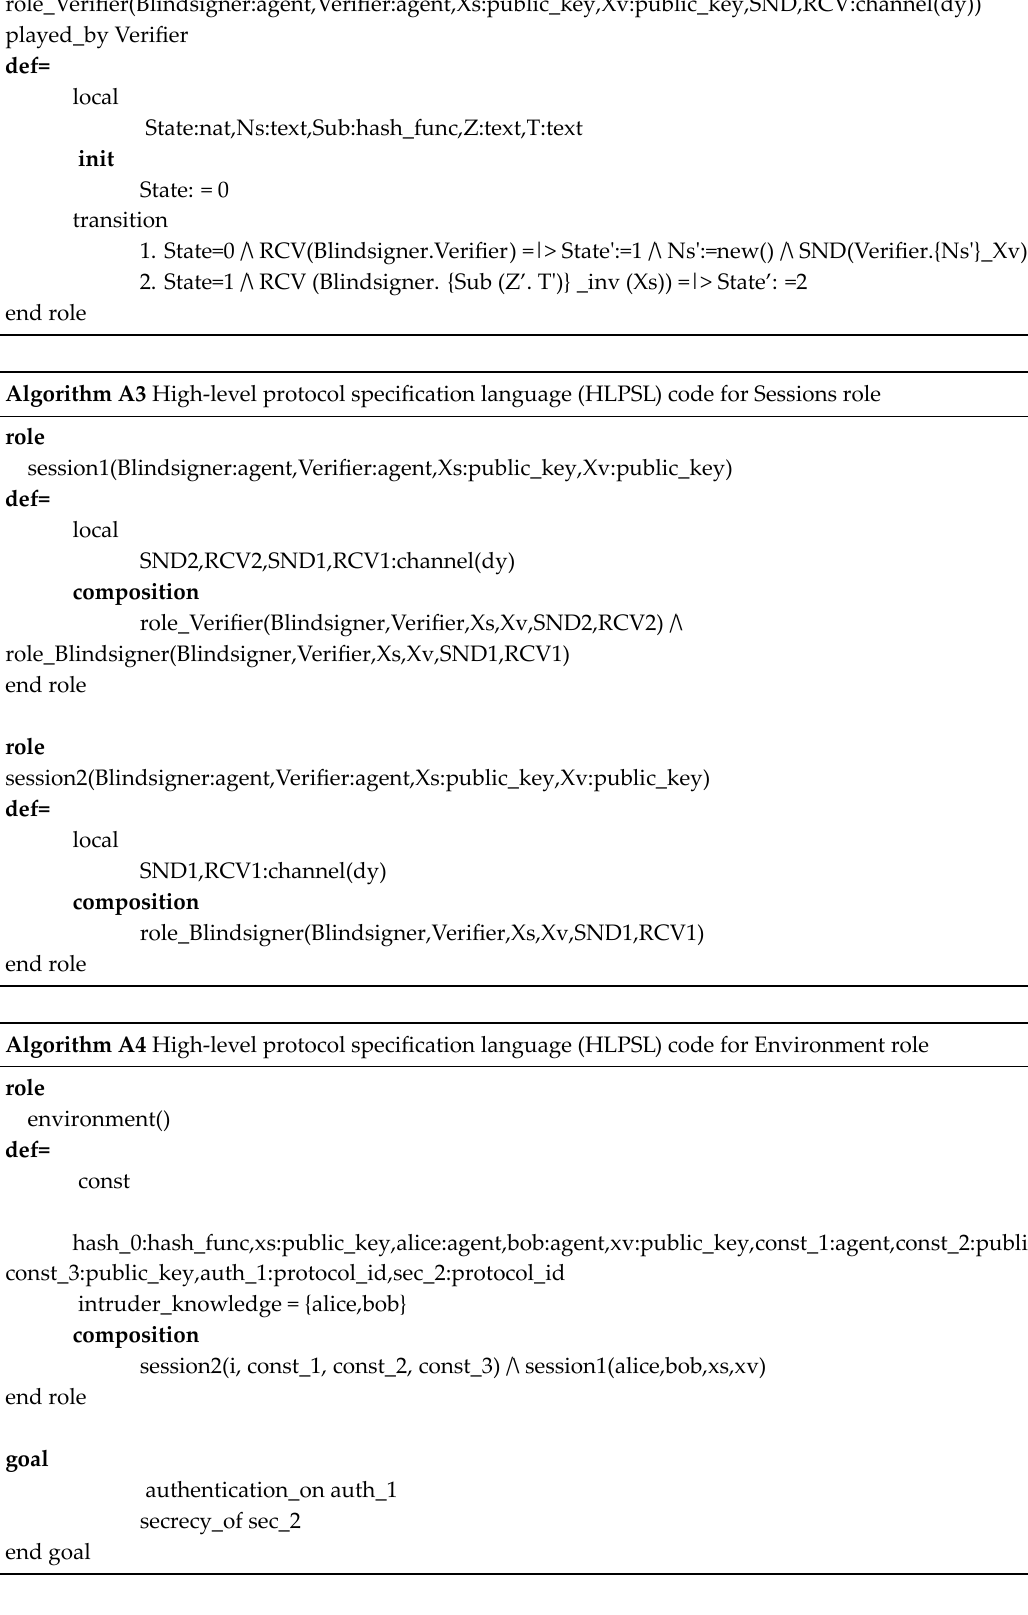
Algorithm A2 High-level protocol specification language (HLPSL) code for Verifier role role